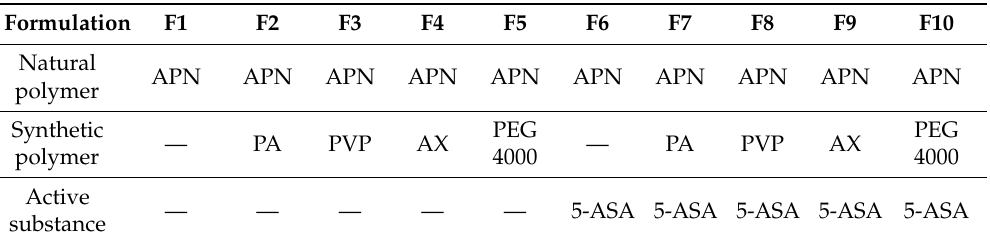
Table 6. Composition of pectin